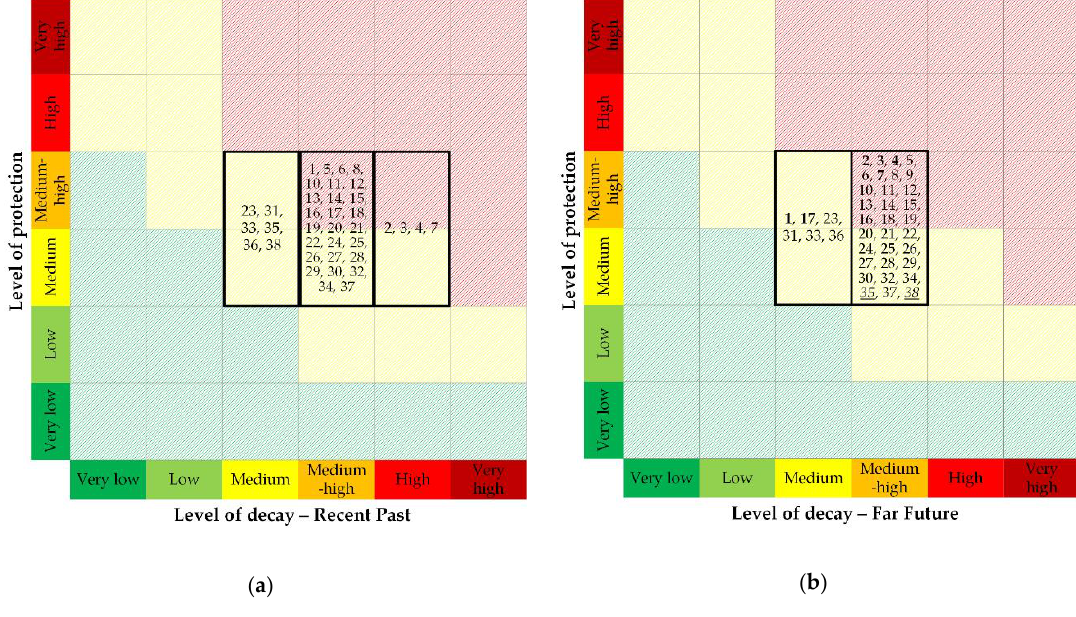
Figure 7. The urgency of interventions in small heavyweight buildings for each ID location in: ( a ) Recent Past (1961–1990); ( b ) Far Future (2071–2100). (Underlined locations in FF: higher decay induced by climate change. Bold locations in FF: lower decay induced by climate change.).